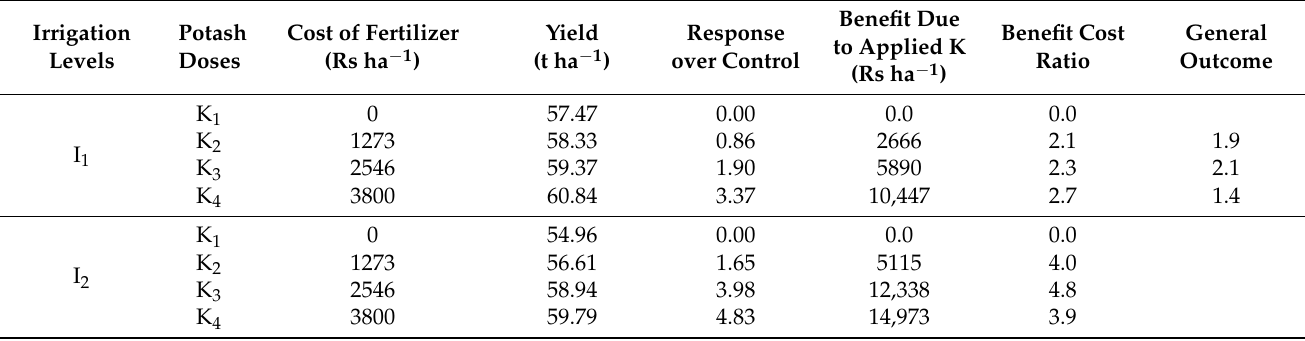
I 1 indicates plots irrigated with sufficient water, while I 2 indicates water-stressed plots, averaged over potassium treatments; K 1 , K 2 , K 3 and